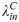
Dynamics for various strengths of chemotactic sources.(A) Migration distance for various strengths of chemotactic sources (λinC = 0.14, 0.82, 1.64). (B) Concentration level of the chemoattractant along the vertical center line at t = 392 min when λinC = 1.64. (C) Time courses of chemotaxis-driven active force strength (|FC|). (D) Time courses of deformation Ld,n⊥ of the nucleus.